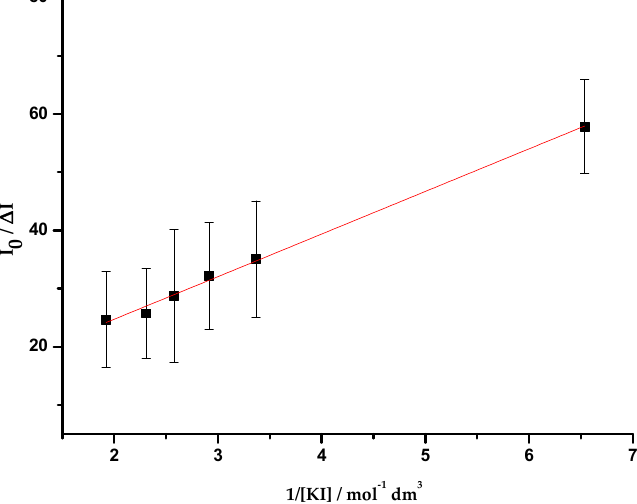
Figure 5. Plot of I 0 / ∆ I vs. the inverse of the iodide concentration (1/[KI]), determined for the quenching of OmpF WT/ E. coli total lipid extract liposomes by iodide, in the presence of Cucpxphen solution, with excitation and emission wavelengths of 290 and 320 nm, respectively. Equation (9) was fitted to the experimental data. Data points are the mean of, at least, three independent experiments. Error bars are the SD. Table 5. Values of the Stern-Volmer constants ( K (cid:2888) and K (cid:2911) ) determined for the quenching of OmpF (WT, W61F and W214F)/ E. coli total extract proteoliposomes by iodide and acrylamide, in the absence and in the presence of cpx and Cucpxphen solutions, by steady-state fluorescence, using Equations (6) and (9). The presented values are the mean of, at least, three independent experiments (±SD).